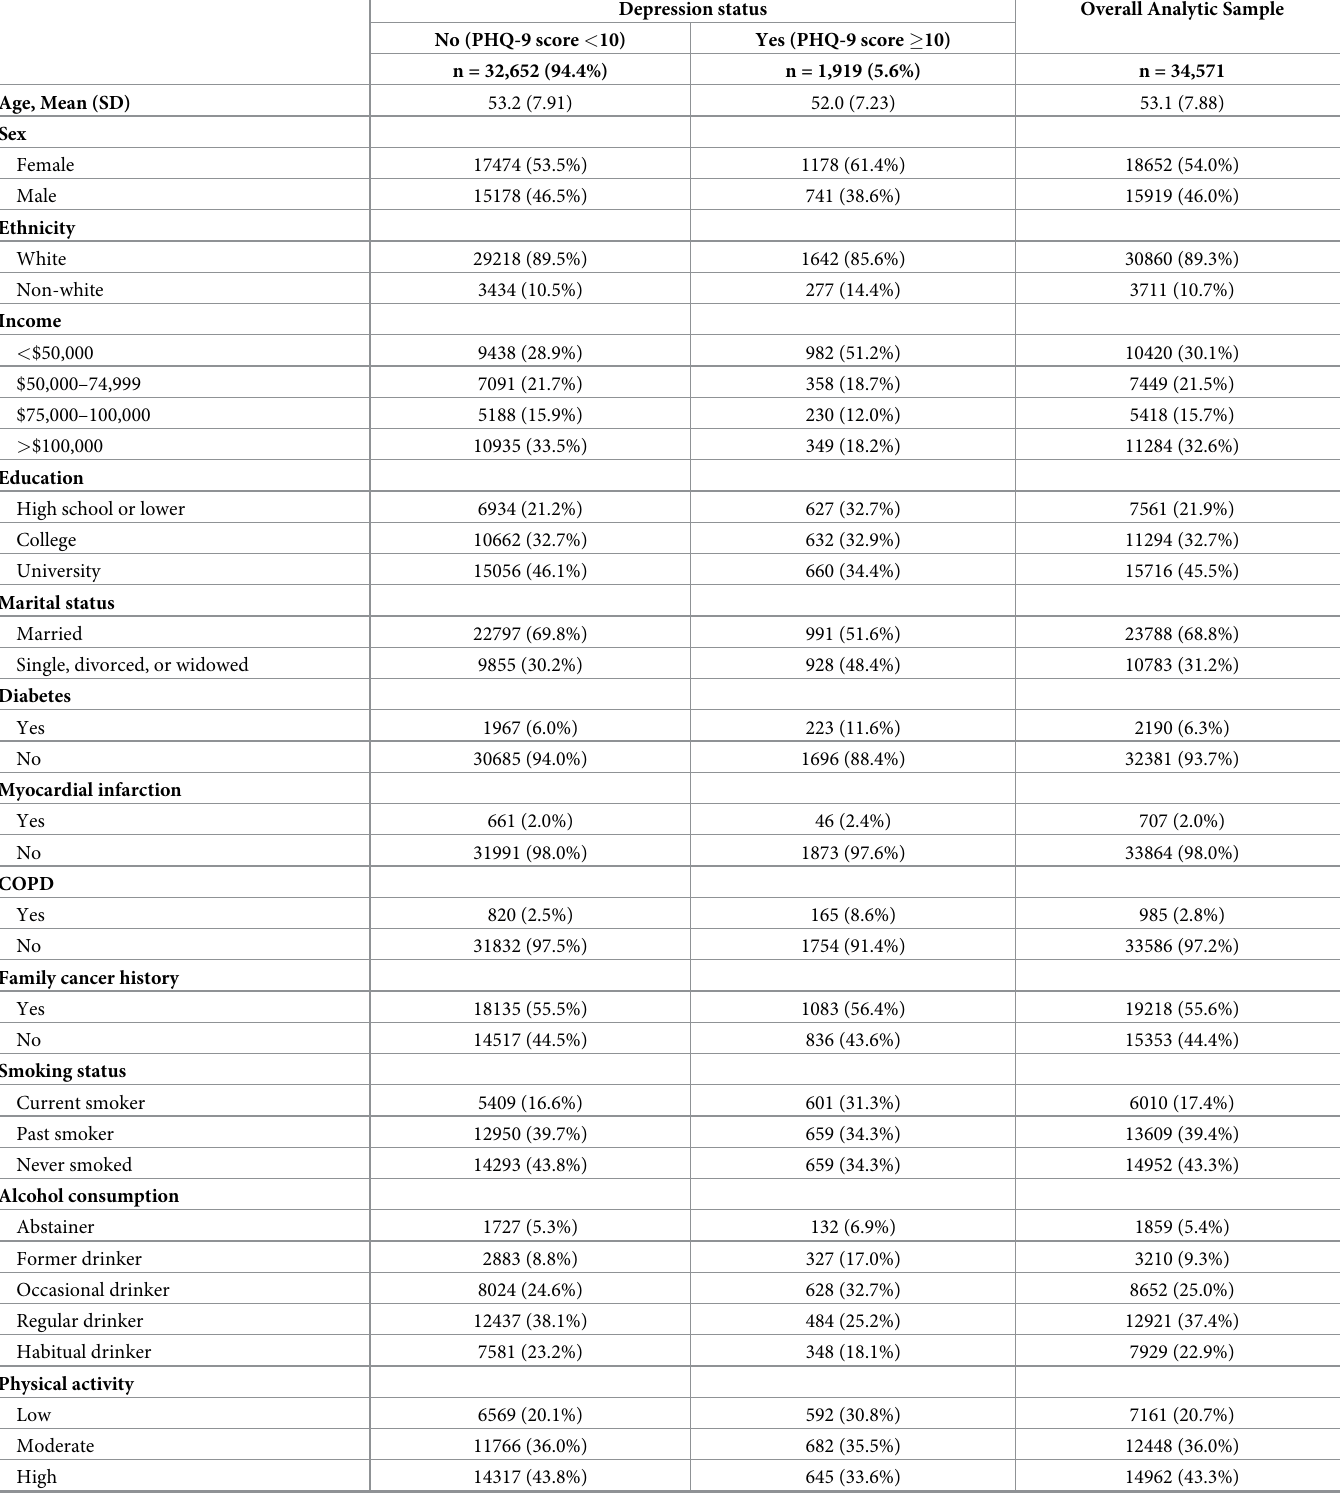
Table 1. Descriptive characteristics of the CARTaGENE sample with comparison of PHQ-9